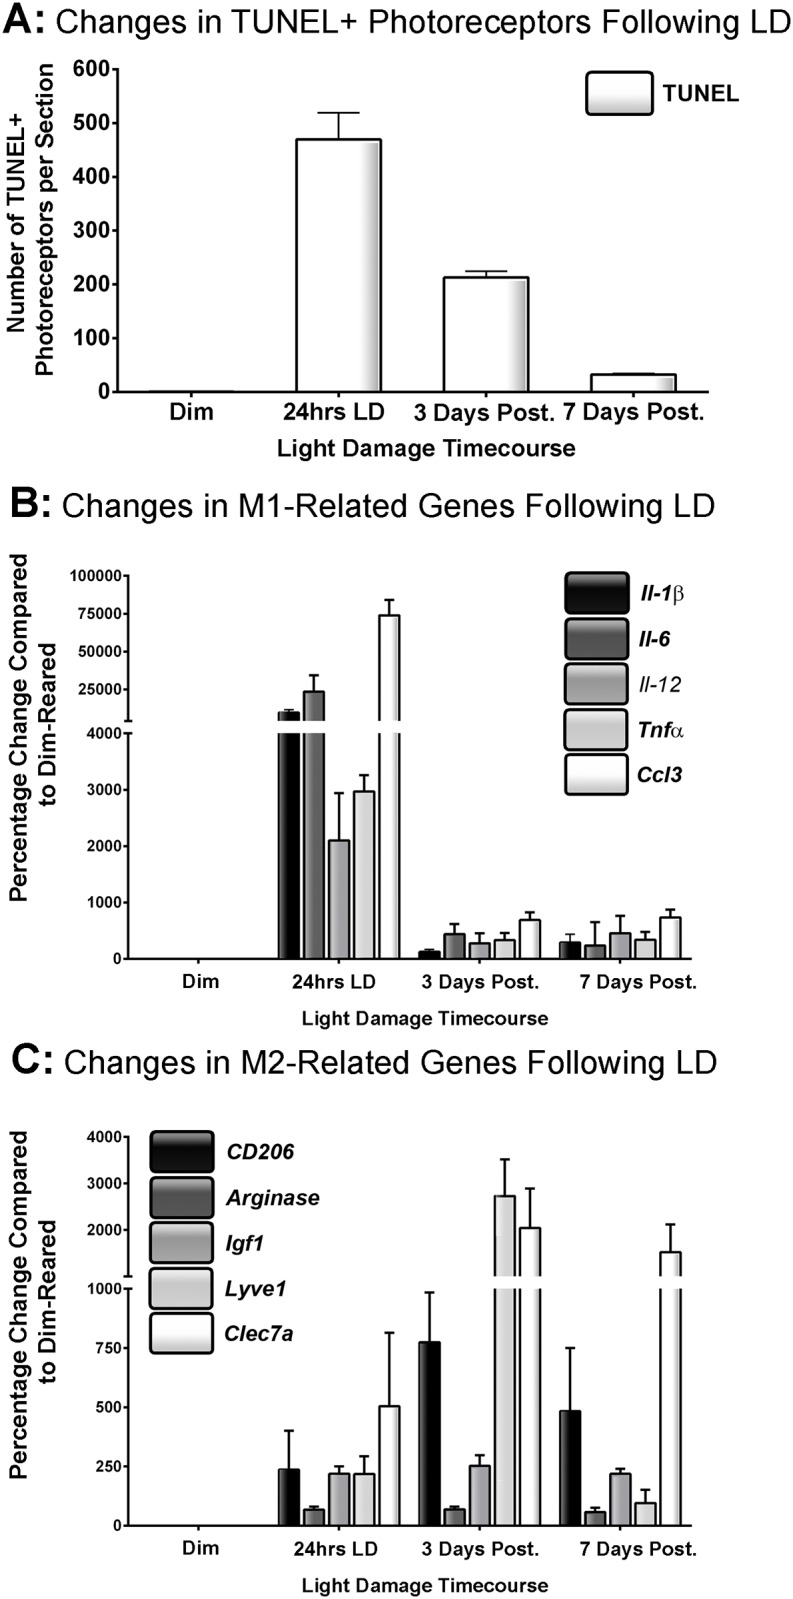
Expression of M1- and M2- associated markers via qPCR following LD.
A: The number TUNEL+ photoreceptors increased profoundly after 24hrs LD. This number decreased progressively during the post-exposure period, though chronic levels of cell death remained after 7 days post-exposure. B: The expression of all M1 genes peaked at 24hrs LD, only to then diminish rapidly during the post-exposure period. Minimal up-regulation in these genes was observed after 7 days. C: M2-associated genes displayed more protracted up-regulation over the LD timecourse. Arginase and Igf1 expression had modest yet consistent up-regulation over time course. Prolonged up-regulation was also evident for CD206, Clec7a, and Lyve1 though with some temporal variation; CD206, Clec7a exhibited strong sustained up-regulation from 3 to 7 days post-exposure, while Lyve1 peaked at 3 days and was vastly reduced after 7. The overall trend in expression for each gene was significant by ANOVA (P < 0.05); N = 5 for each timepoint.